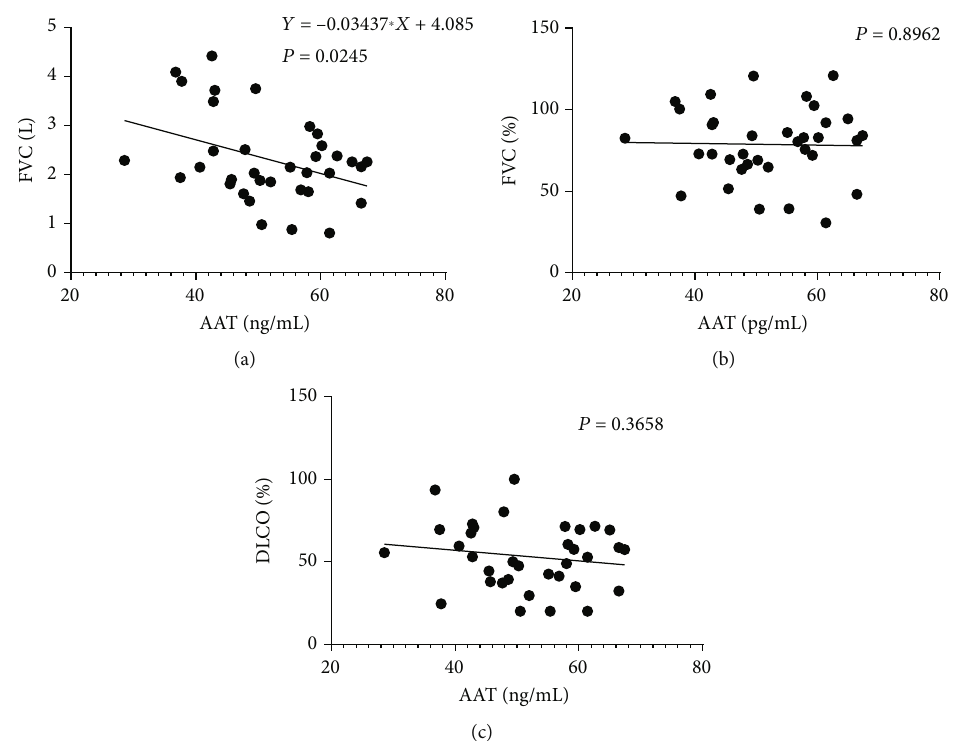
Figure 4: AAT might not be a good predictor of poor lung function. (a) There was a negative correlation between AAT and FVC ( r = − 0 : 034 , P = 0 : 025 ). (b) No correlation of AAT with FVC% ( r = − 0 : 052 , P = 0 : 896 ). (c) No correlation of AAT with DLCO% ( r = − 0 : 323 , P = 0 : 366